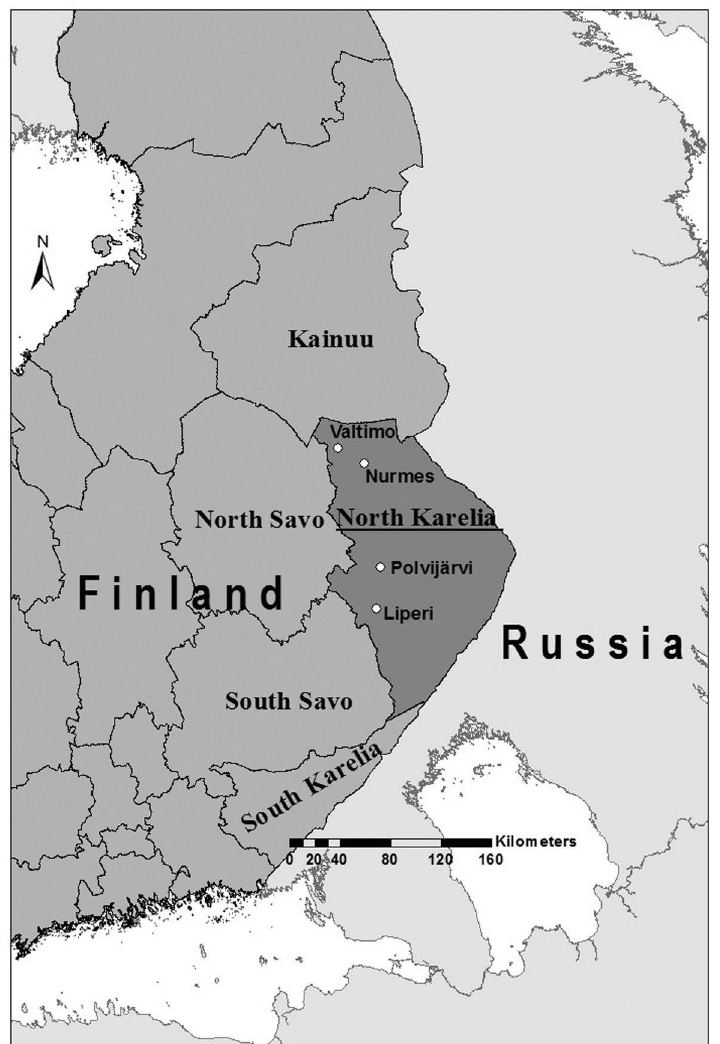
Fig. 1. location of North Karelia in Finland and municipalities where the research was